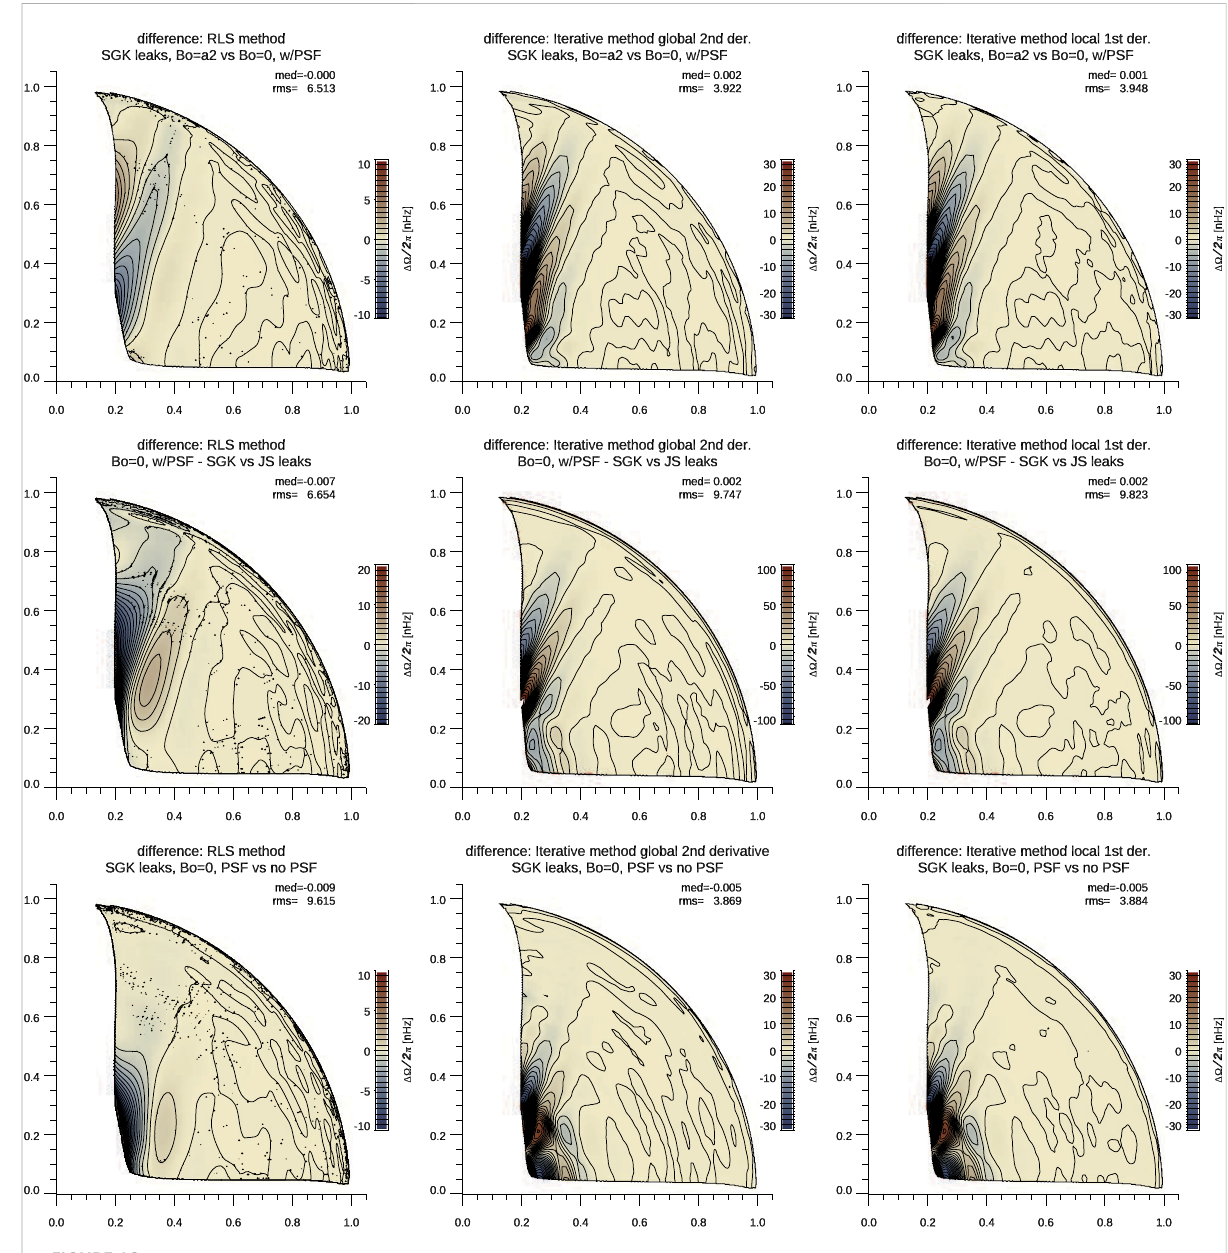
FIGURE 16 Differences in inverted rotation pro fi les when using different methods (rows) and different splittings (columns). Left to right: the RLS method, the iterative global second-derivative method, and the iterative local fi rst-derivative method. Top to bottom: SGK leaks, including the PSF but with B o (cid:3) a B o (cid:3) 0; SGK vs . JS leaks, including the PSF and with B o (cid:3) 0; and SGK leaks, B o (cid:3) 0 but with or without including the 2 or